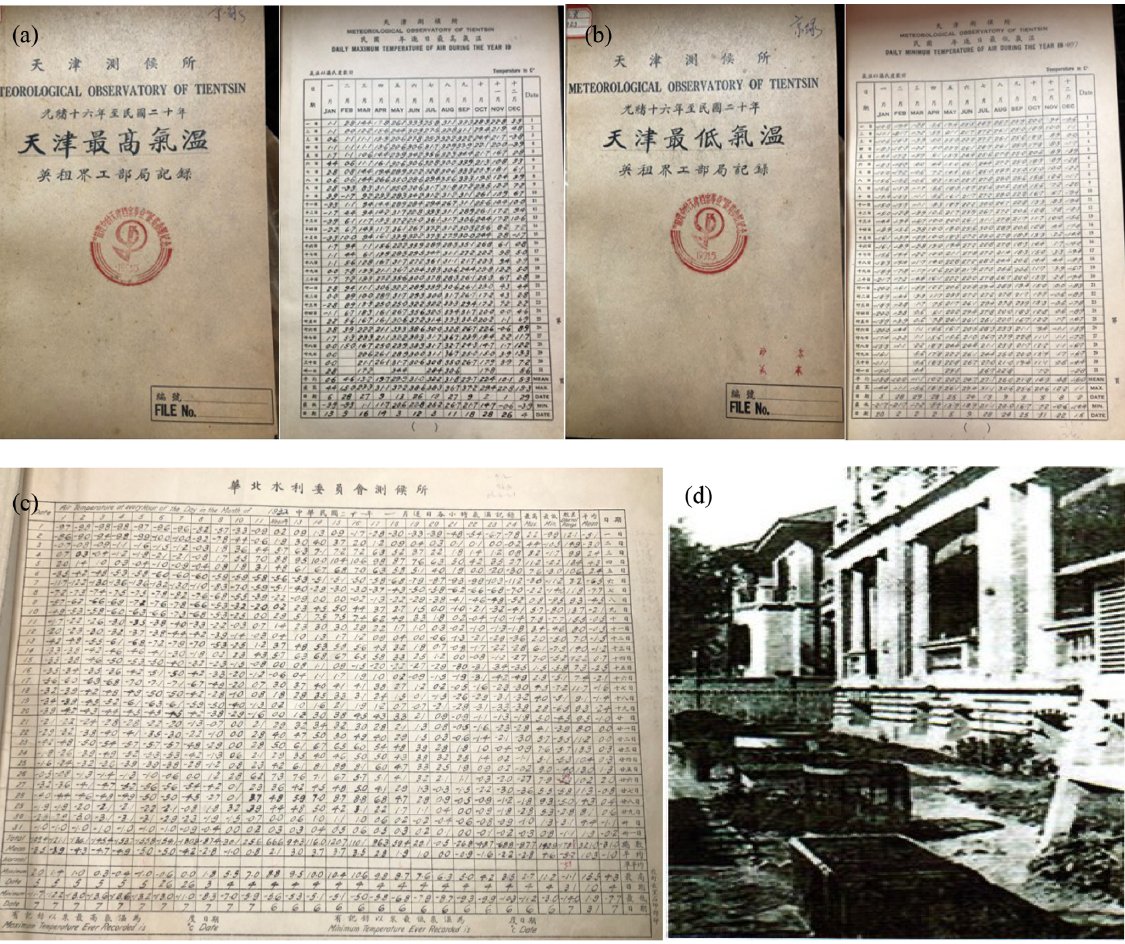
Figure 1. The handwritten observation records of Tianjin before 1950: (a) and (b) for records of maximum and minimum temperatures from the Department of Industry Agency of the British Concession in Tianjin and (c) for records from the Water Conservancy Commission of North China. (d) Tianjin Observatory at 22 Ziyou Road. These photographs were provided by the Tianjin Meteorological Archive, Tianjin Meteorological